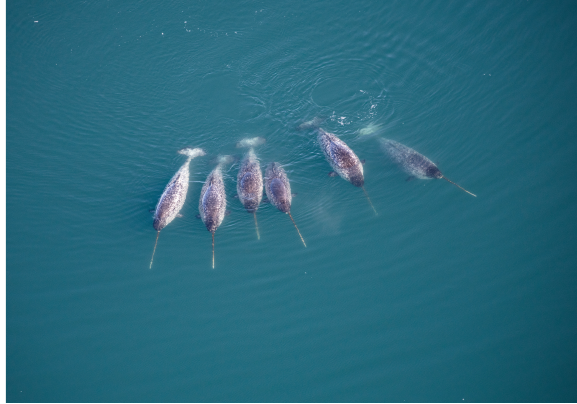
Figure 4. Narwhals from above in excellent sighting conditions (Photo: C. Egevang). Aerial